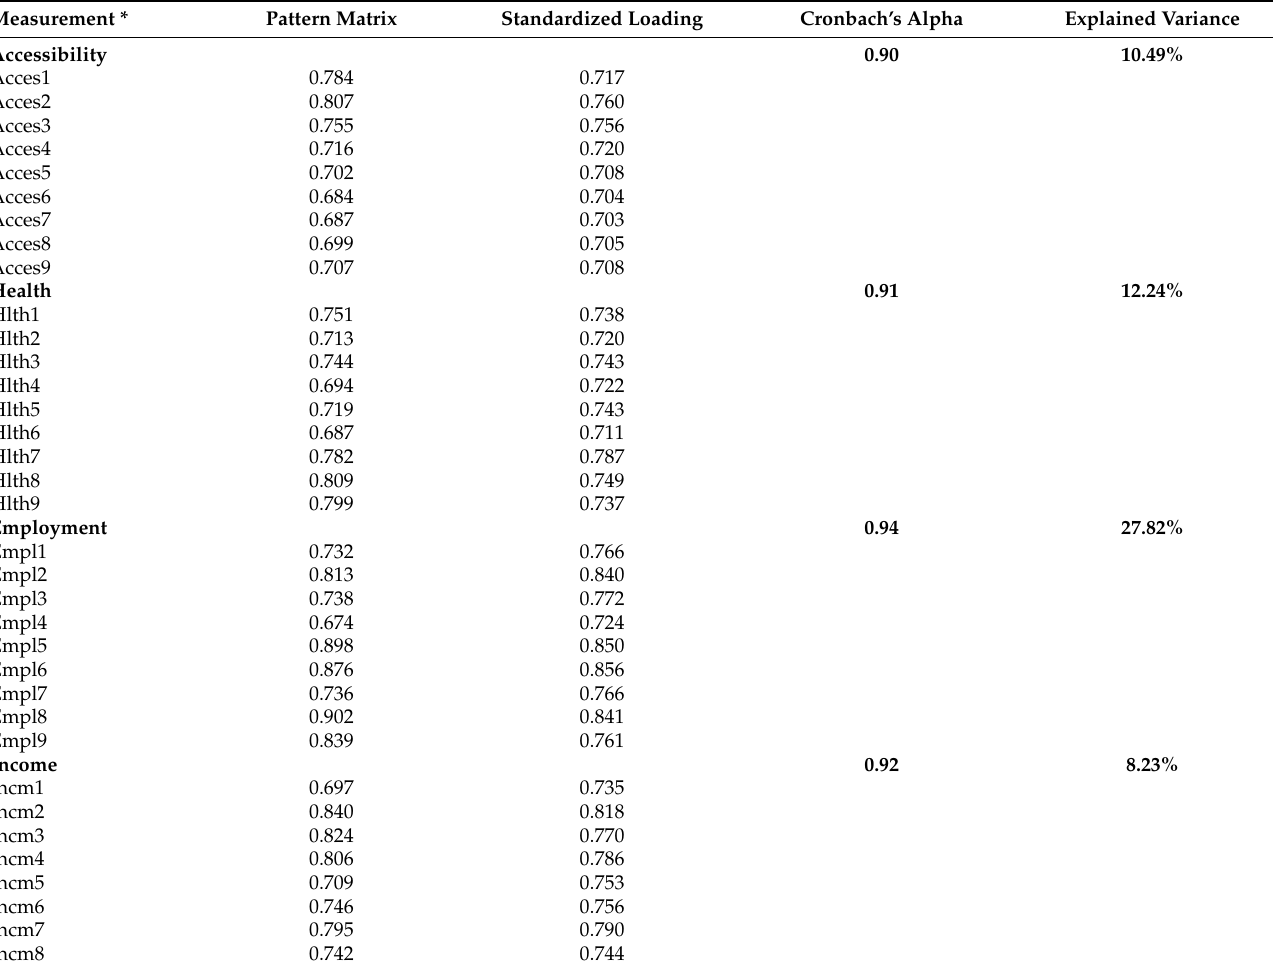
Table 2. Pattern Matrix, Communalities, Average Variance Extracted, Explained Variance and Standardized